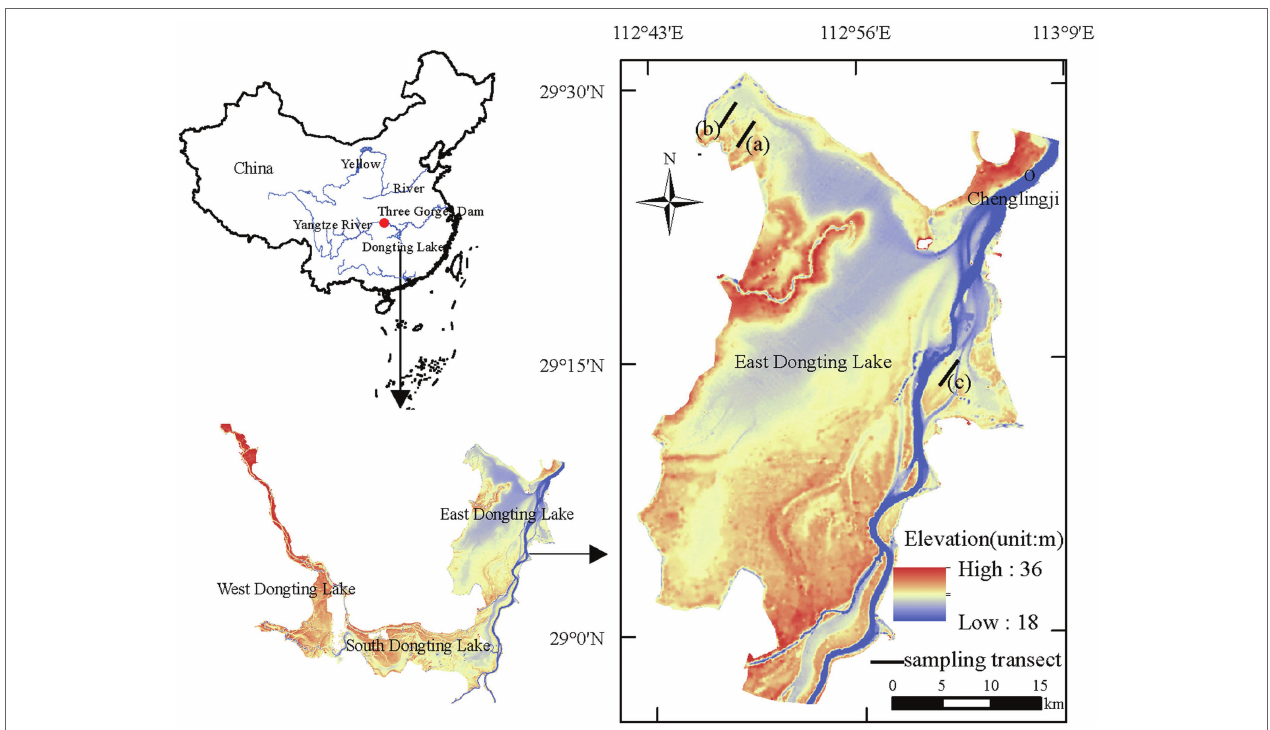
FIGURE 1 | Locations of the sampling sites in East Dongting Lake, China. (a) Carex community, (b) Miscanthus community, and (c) Polygonum